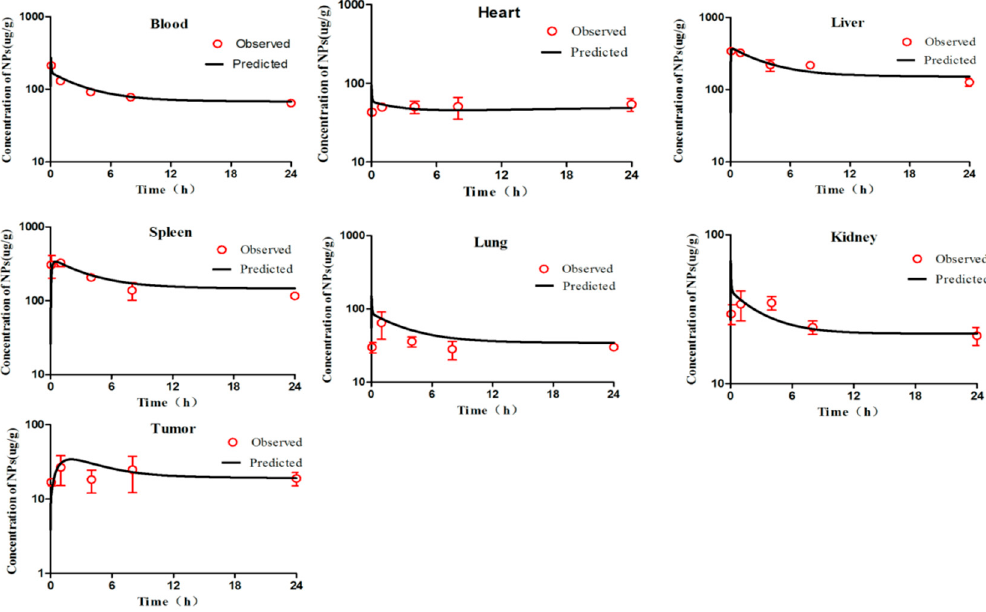
Figure 3. Simulated and experimentally measured concentration–time curves of mPEG5k-28.57%-80 nm NPs in mouse blood and tissues after intravenous injection.